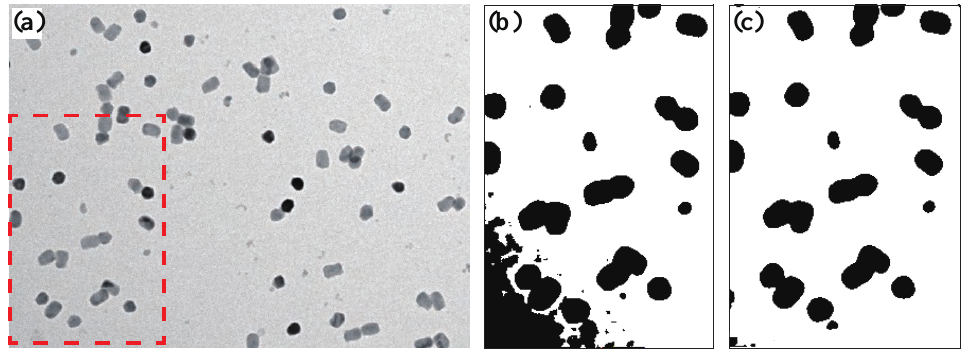
Figure 2. Background pre-processing and removal. ( a ) Raw TEM image with uneven background. ( b ) After global thresholding. The area shown here is highlighted in red dashed line in ( a ). ( c ) After dynamic thresholding of the same area in ( b